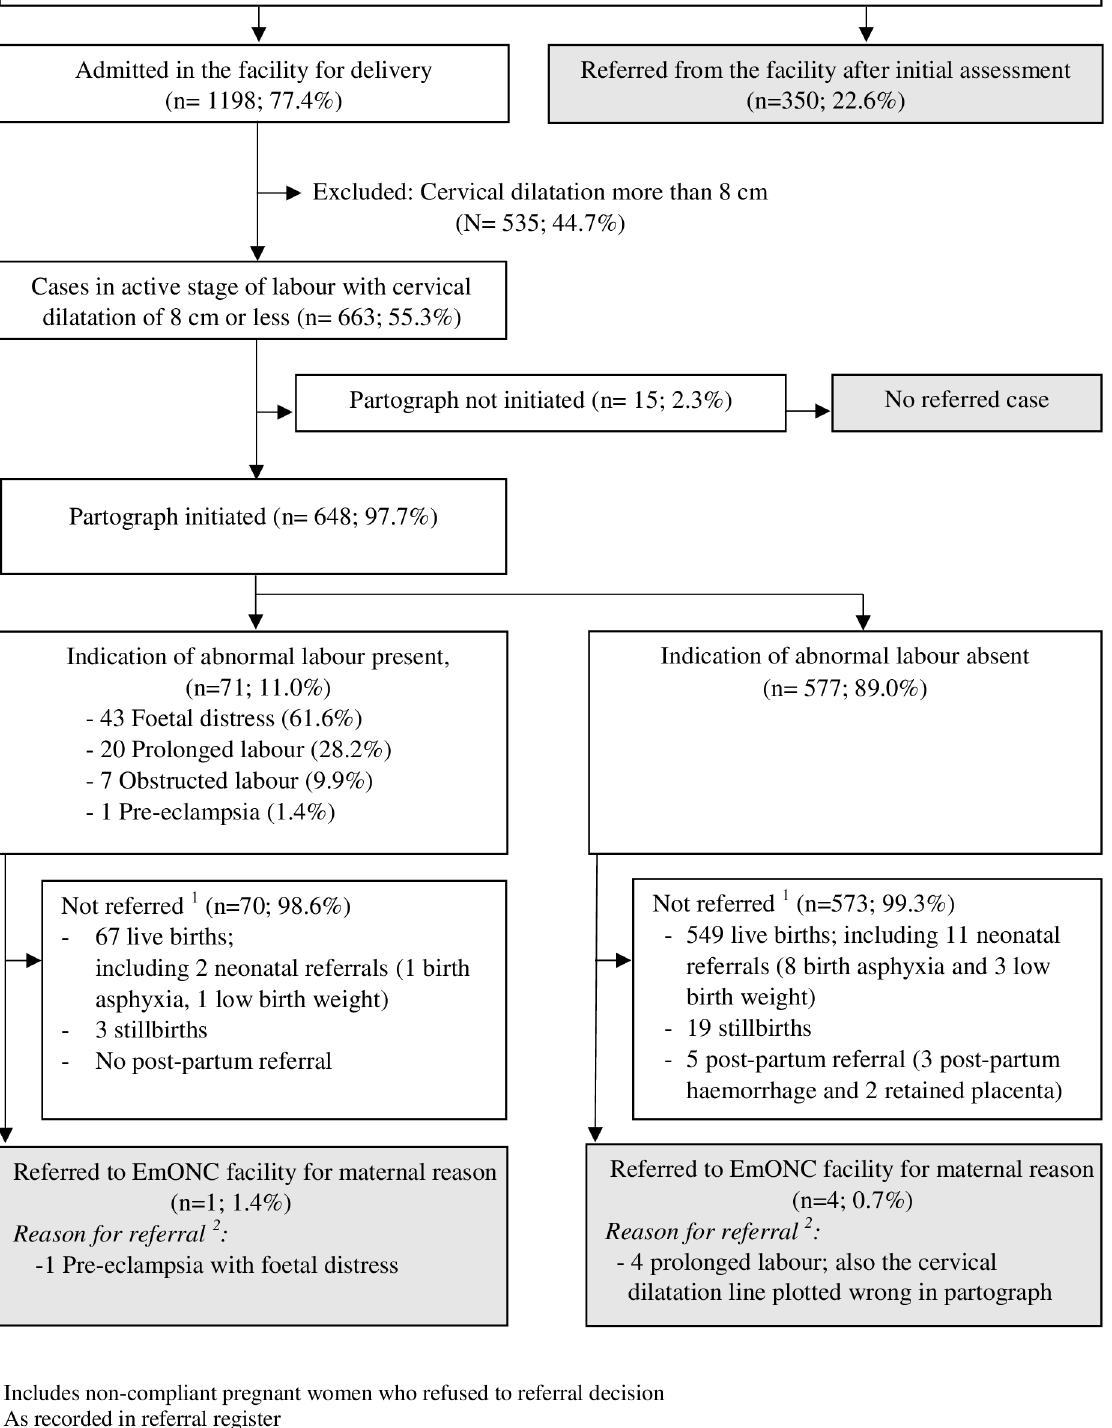
PLOS ONE | https://doi.org/10.1371/journal.pone.0203617 September 6,